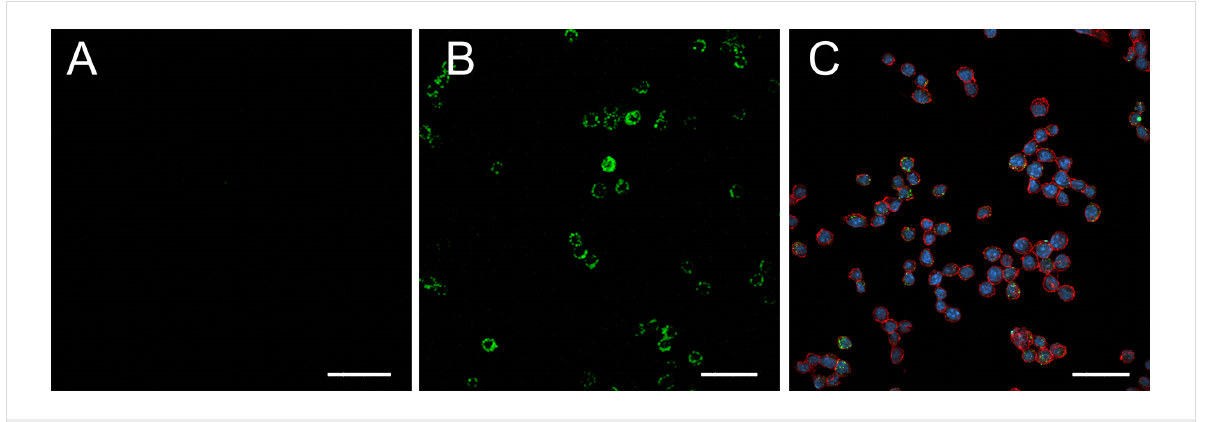
Figure 4: Confocal fluorescence microscopy images of fluorescent labeled VCAM1-PEG5000Au CPMV particles. RAW246.7 actin filaments were labeled with DY-554 phalloidin (red) and DAPI (blue). (A) IgG-PEG5000 Au-CPMV (B) VCAM1-PEG5000 Au-CPMV showing the binding of the particles to the cells surface and (C) merged image of the cells with VCAM1-PEG5000 Au-CPMV showing stained cells and the binding of the particles. Scale bars: 100 μ m.